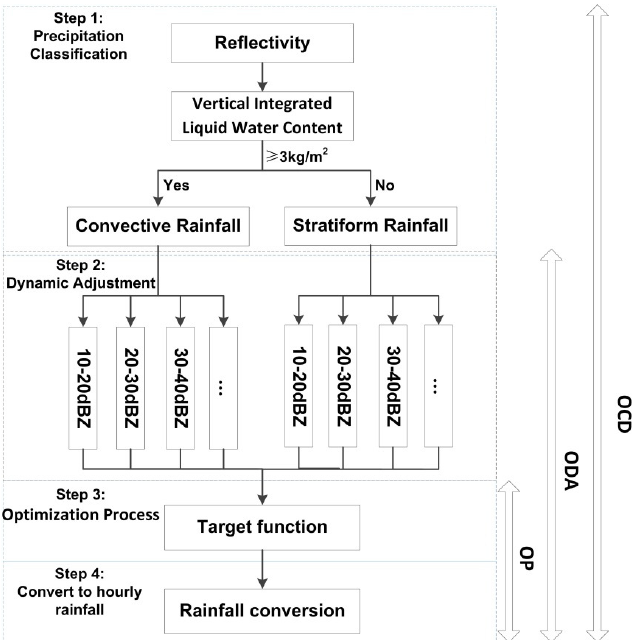
Figure 2. Flow diagram of the QPE algorithm.